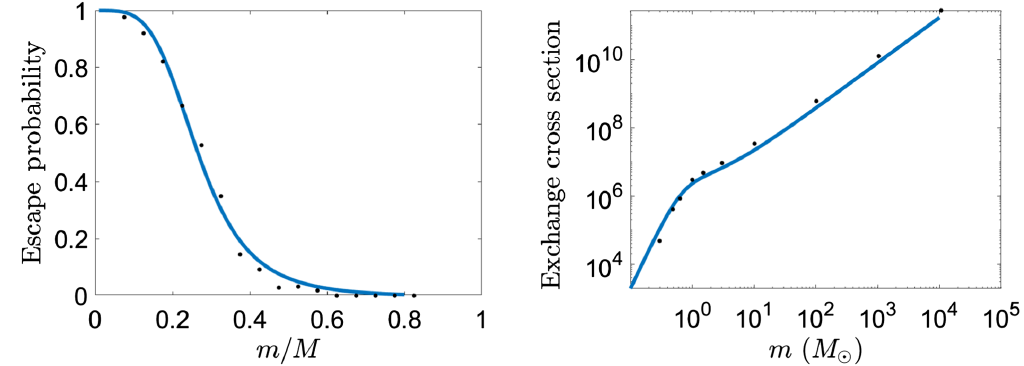
FIG. 1. Left: probability that a star of mass m escapes, where m a ¼ m b ¼ 1 M ⊙ , compared with data from Ref. [8]. Right: exchange cross section, in units of the geometric cross section, π a 2 0 , for binary masses equal to 1 M ⊙ , and third star mass m , which arrives with , compared with data from Ref. initial velocity v ¼ 0 . 001 v orb